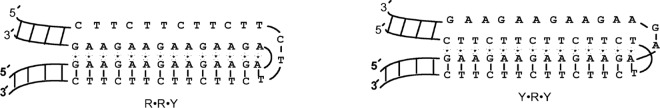
Purine and pyrimidine H-DNA motifs formed at (GAA)n repeats.